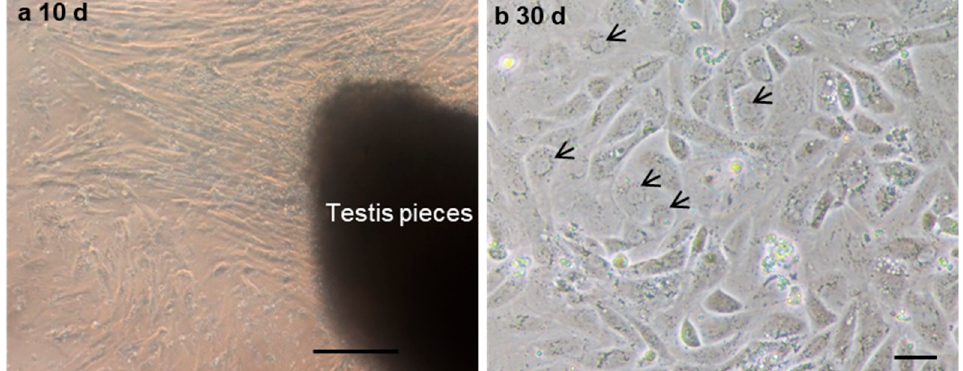
Figure 3. The in vitro culture of cryopreserved testicular cells. The testicular cells were cultured at day 10 ( a ) and day 30 ( b ). Arrows indicate the nuclei of cells. Scale bars, ( a ) 100; ( b ) 25 µm.